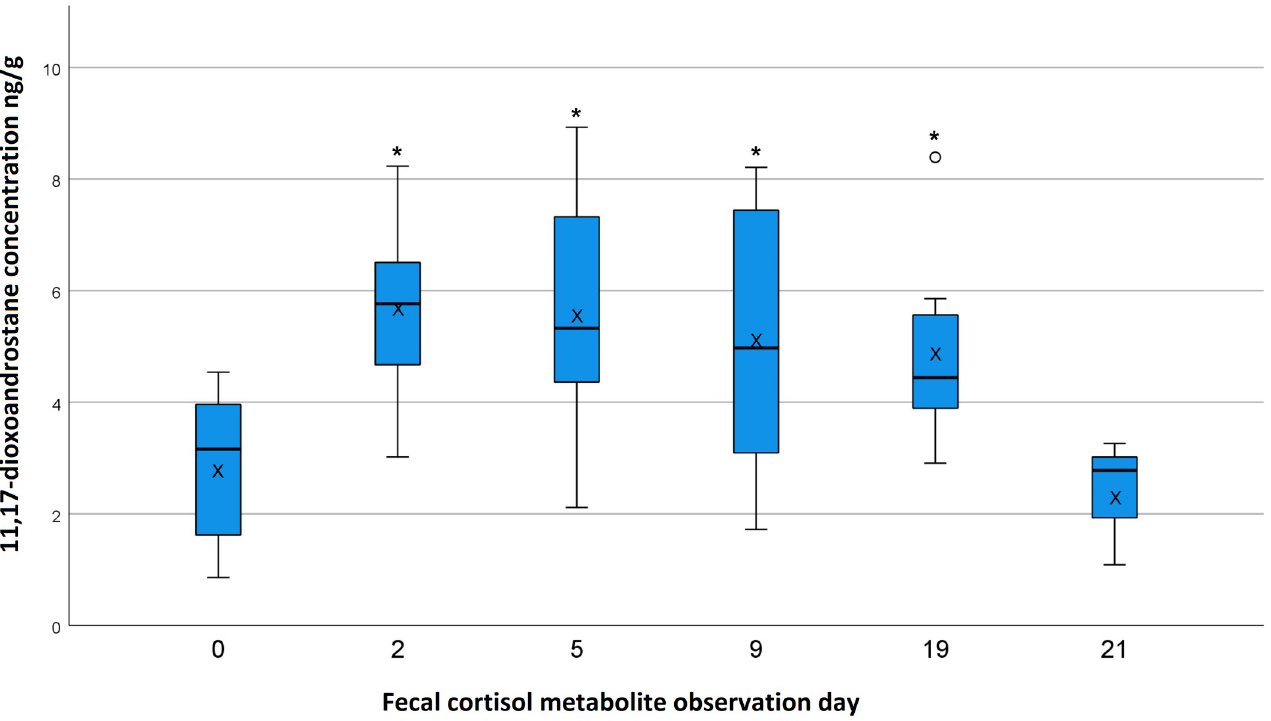
Fig 2. Cortisol metabolite levels throughout the observation period. Note that fecal cortisol metabolite observation day 2 is the day of weaning (see Fig 1). The cortisol metabolite concentrations that differ significantly to those on day 0 are labeled with a � symbol. The concentration is given in ng/g of feces. P -values for each plasma cortisol observation day compared with day 0: day 2: p < 0.001; day 5: p < 0.001; day 9: p = 0.001; day 19: p = 0.003; and day 21: p = 0.462. Numbers of included foals per day: days 0–9: 10; day 19: 6; day 21: 3. One foal (F10) was excluded on day 19 because of falsified results (labeled with a ˚ symbol). The boxplots show the median values (black lines), the mean values (black x), the upper and lower quartiles (blue boxes), and the 5th and 95th percentiles (whiskers).